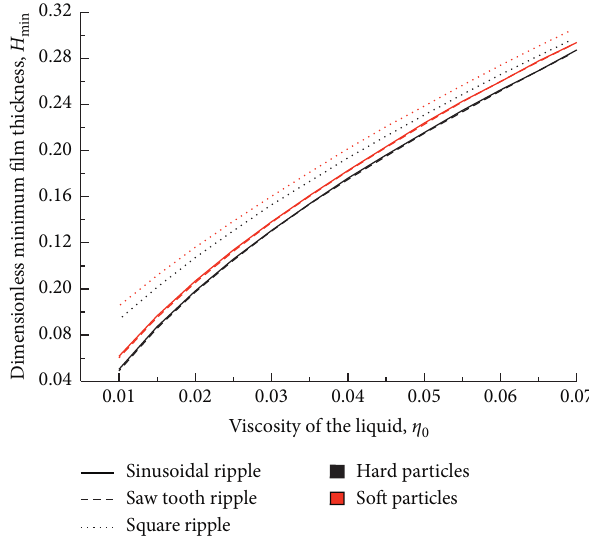
Figure 16: Nondimensional minimum film thickness with dif- ferent initial